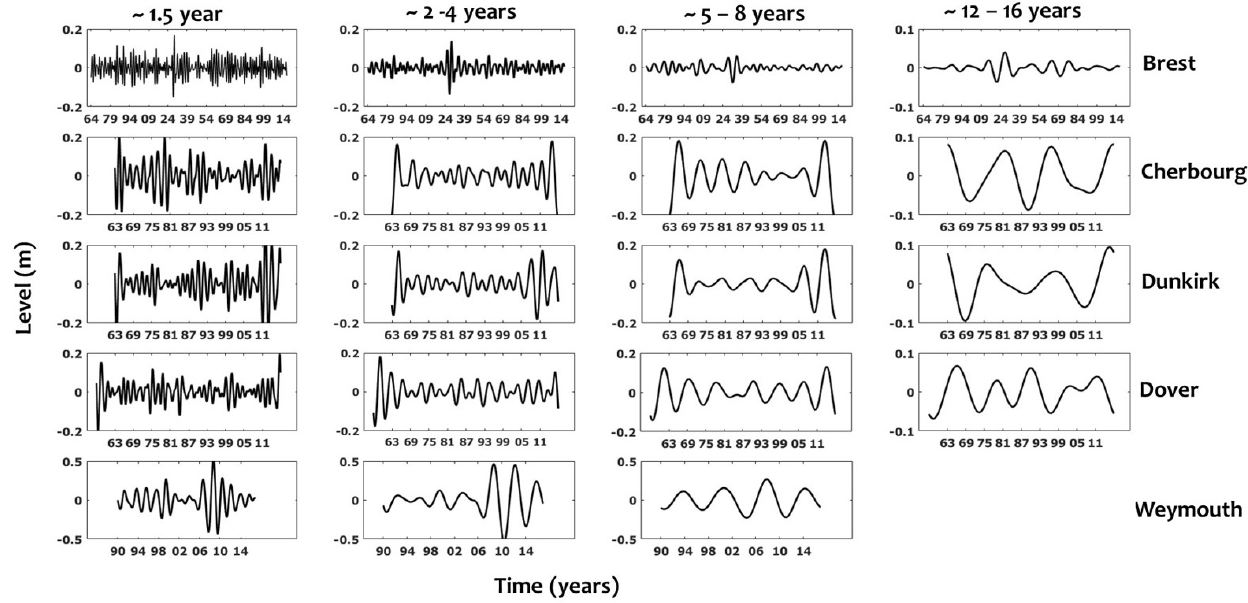
Figure 4. Wavelet details (components) resulting from the multi-resolution analysis of surges at the interannual ( ∼ 1 . 5, ∼ 2–4 and ∼ 5– 8 years) and interdecadal ( ∼ 12–16 years) timescales for all sites (Brest, Cherbourg, Dunkirk, Dover and Weymouth).